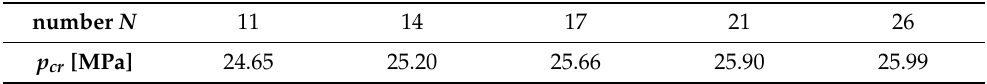
Table 2. Critical static load p cr of the composite plate model with Poisson’s ratio ν = − 0.9 for auxetic facings radially compressed on the inner edge versus a different numbers of discrete points N .